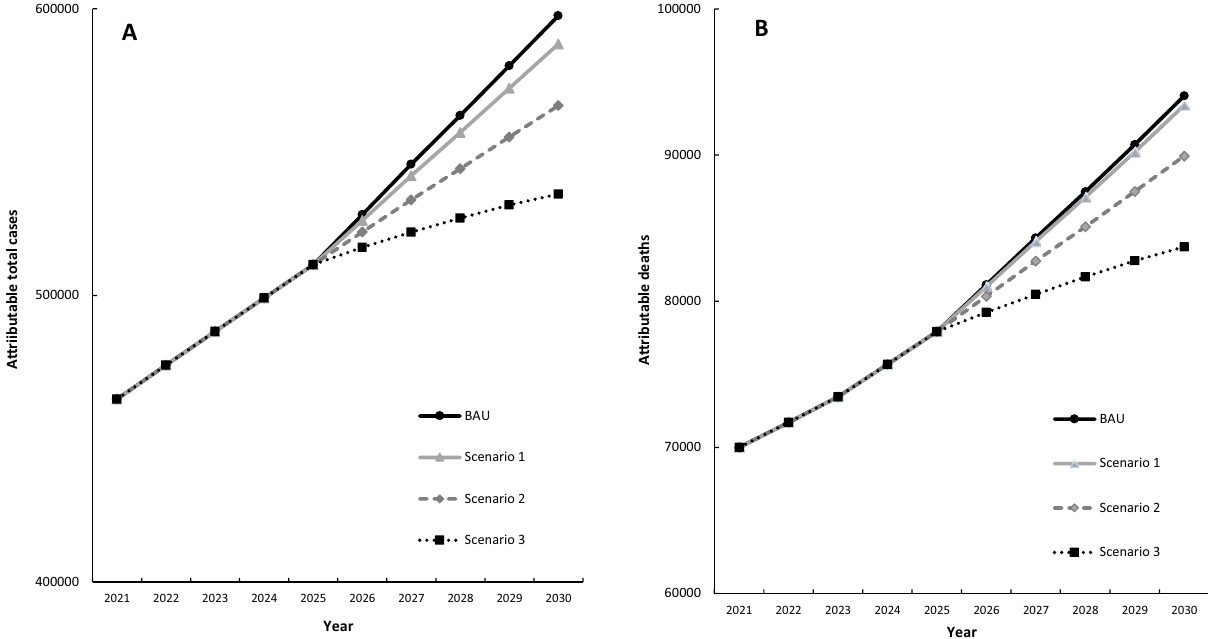
Figure 1. Trends in total NCD cases ( A ) and deaths ( B ) attributable to overweight from 2021 to 2030, considering the continuity of the current trajectory of BMI increases (BAU—business as usual) and different counterfactual scenarios of changes in the prevalence of overweight in